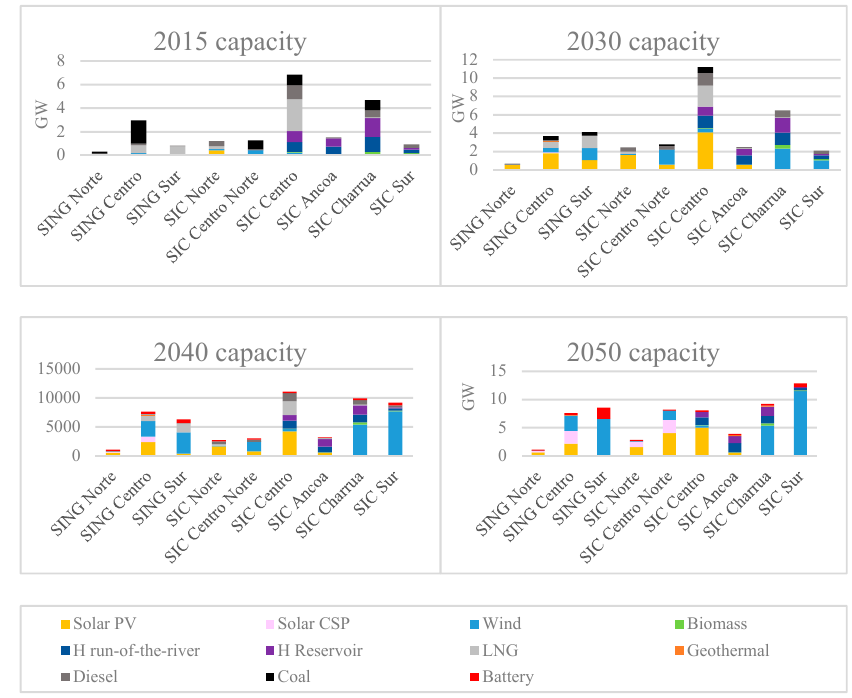
Figure 6. Evolution of installed capacities by region for the 100% renewable